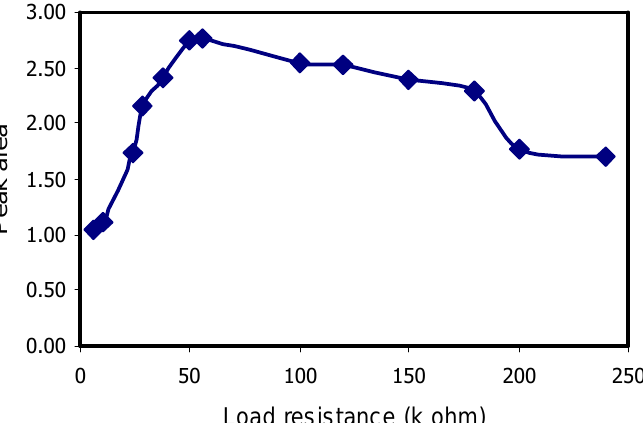
Figure 5. Relationship between peak area and load resistance of circuit sensor (the circuit of R